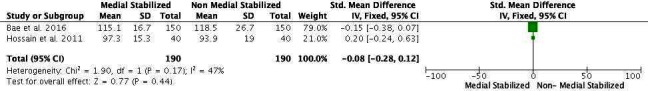
 Forest plot of preoperative Knee ROM of medial stabilized group and non- medial stabilized group (SD: Standard Deviation; CI: Confidence Interval).